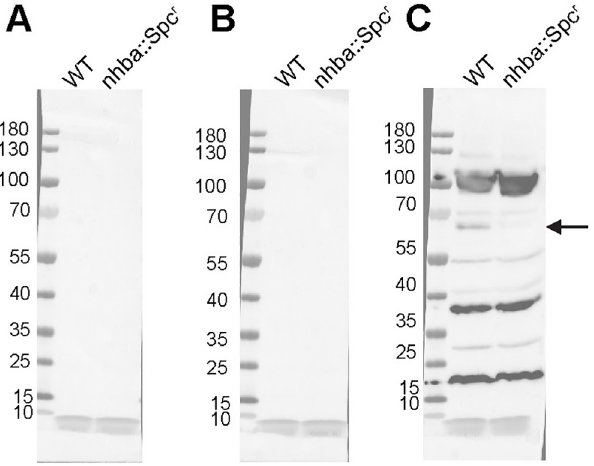
Fig 9. 4CMenB-immunized mice have cross-reactive antibodies against Ng NHBA. Crude OMVs (~10 μ g) prepared from Ng strains FA1090 or FA1090- Δ Nhba were fractionated by SDS-PAGE and transferred to nitrocellulose membranes. Western blot was performed using sera (1:2,500) from mice immunized with 4CMenB (right panel) or given alum alone (middle panel) or PBS (left panel). A band of ~ 66 kD is recognized by the immune serum in OMVs from the wild-type strain but not in OMVs from the isogenic nhba mutant FA1090- Δ Nhba.